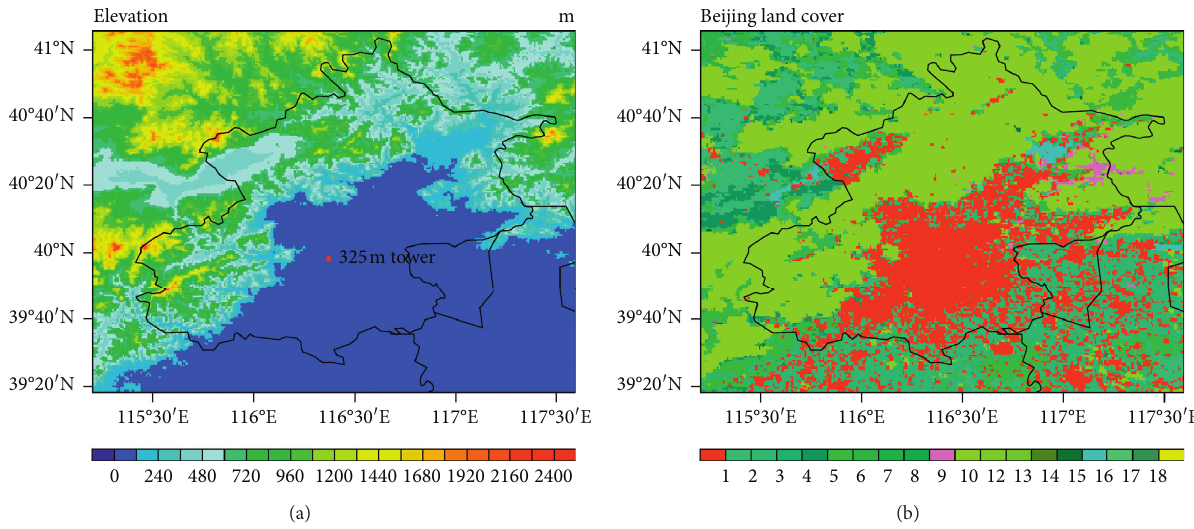
Figure 1: (a) Shaded relief elevation above sea level (m) and the position of the 325m tower; (b) USGS LUCs based on MODIS (1, urban and built-up land; 2, dryland cropland and pasture; 3, irrigated cropland and pasture; 4, mixed dryland/irrigated cropland and pasture; 5, cropland/grassland mosaic; 6, cropland/woodland mosaic; 7, grassland; 8, shrubland; 9, mixed shrubland/grassland; 10, savanna; 11, deciduous broadleaf forest; 12, deciduous needleleaf forest; 13, evergreen broadleaf forest; 14, evergreen needleleaf forest; 15, mixed forest; 16, water bodies; 17, herbaceous wetland; 18, wooded wetland; 19, barren or sparsely